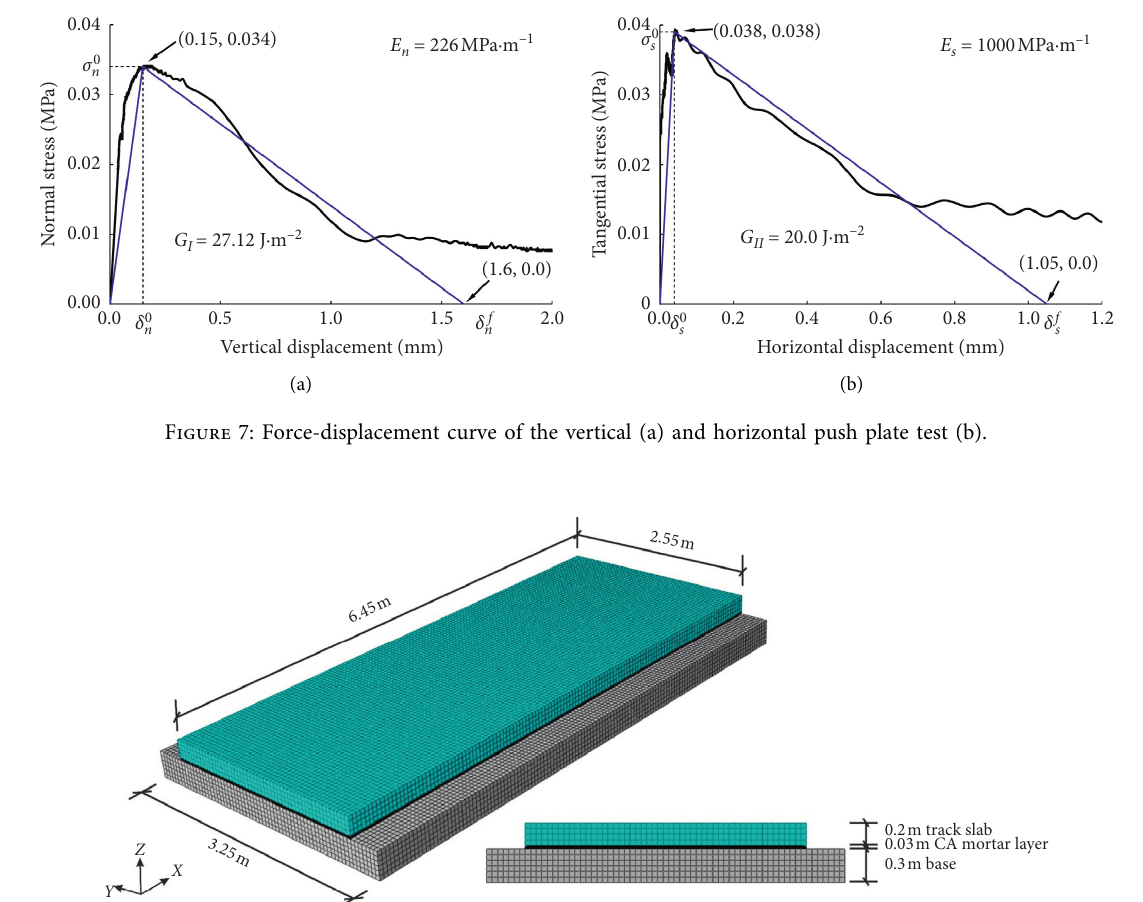
Figure 8: Finite element model of CRTS II SBTS.